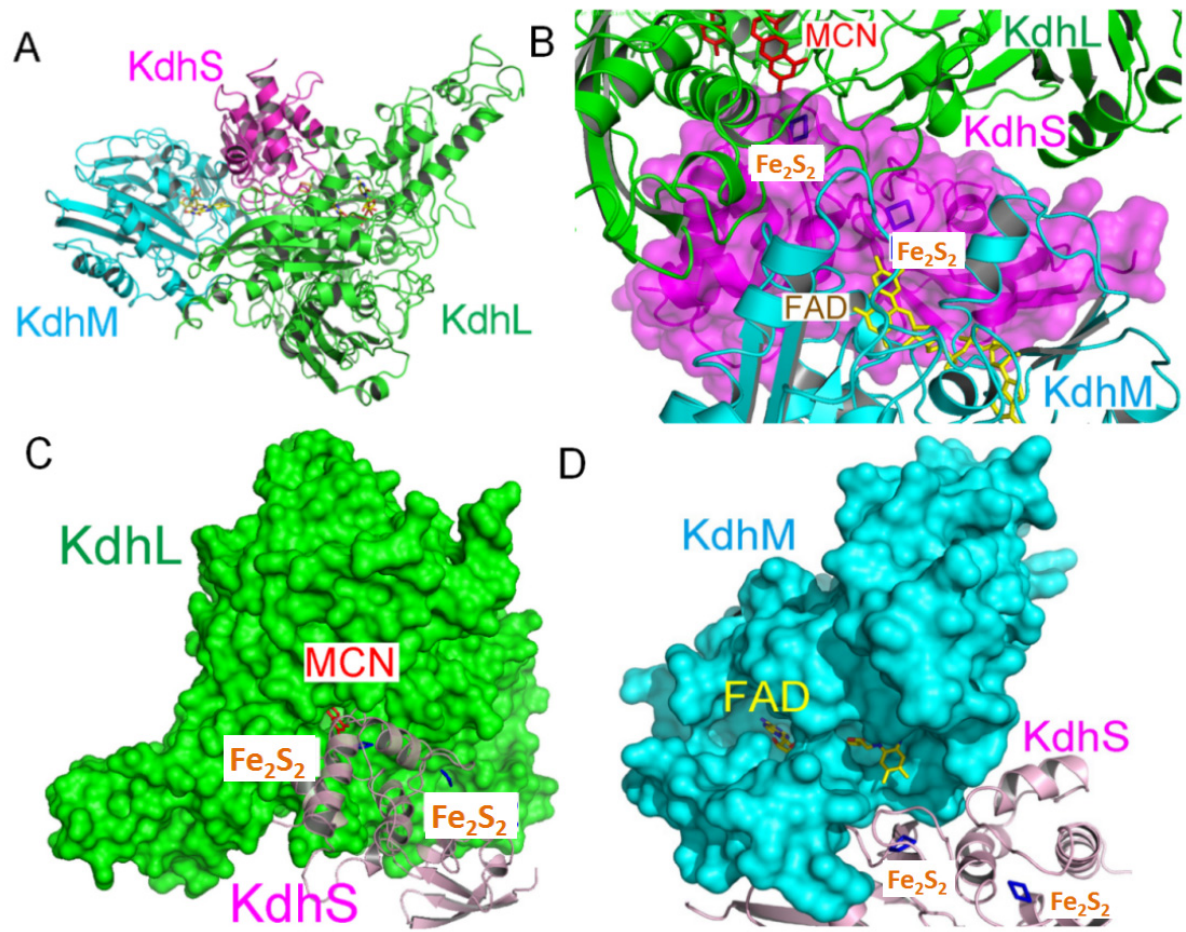
Figure 1. Crystal structure of Kdh. ( A ) Structure of the Kdh holoenzyme. KdhL, KdhM, and KdhS are colored in green, cyan, and magenta, respectively. Their associated cofactors are shown as stick representations. ( B ) The 2 Fe 2 S 2 iron-sulfur clusters associated with KdhS are deeply buried and well-protected by the Kdh enzyme. The surface of KdhS is set as transparent. ( C ) The MCD cofactor associated with KdhL is also restricted from exterior access. The surface of KdhL is set as opaque. ( D ) The FAD cofactor associated with KdhM is relatively more open to the outside of the enzyme, allowing it to unload the electrons transferred from the substrate through the cofactor chain. The surface of KdhM is set as opaque.